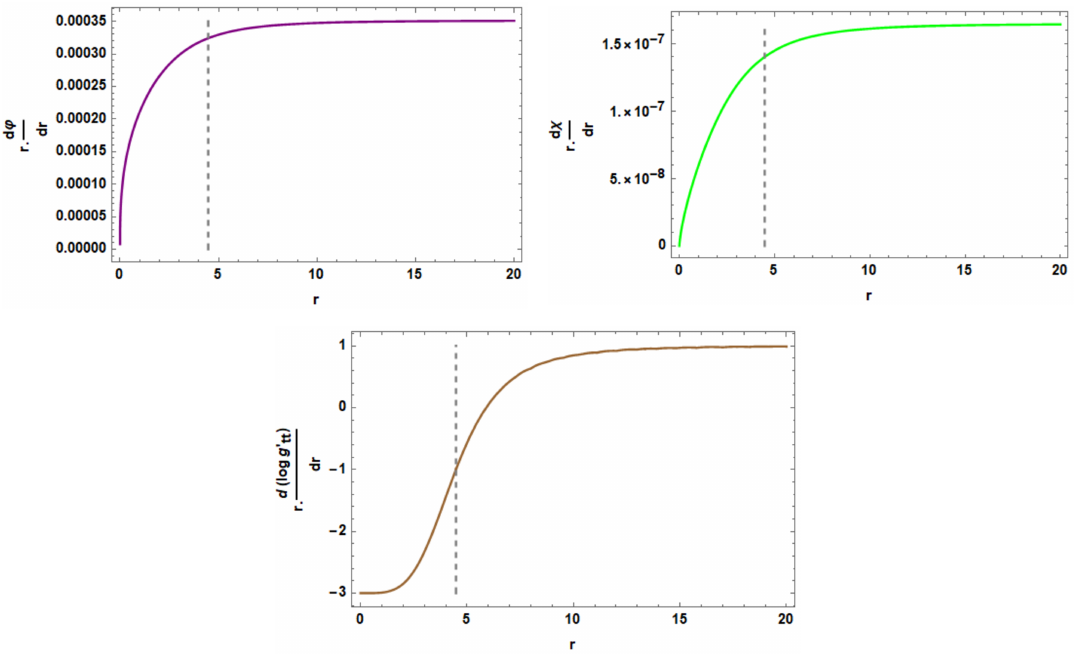
Figure 20. Here V ϕ is plotted as a function of ϕ . Left figure is showing the (expected) local structure of V ϕ near ϕ = 0 whereas the right figure corresponds to global structure of the